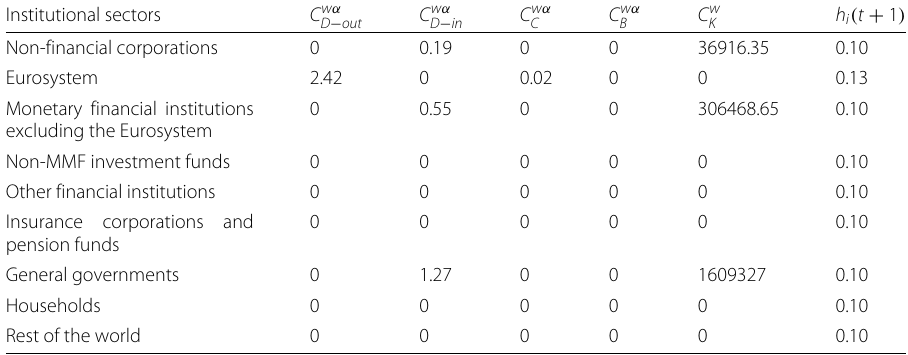
Table 3 Network statistics - APP security